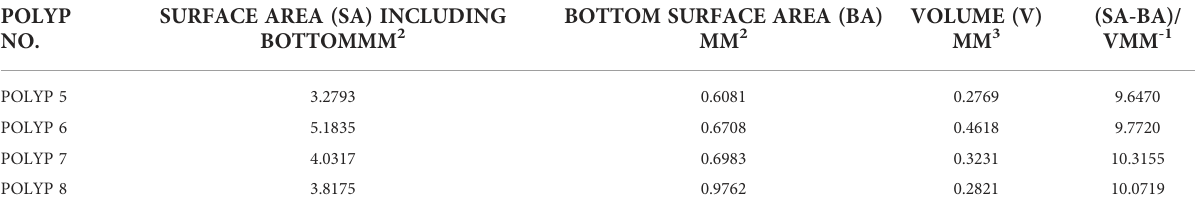
TABLE 1 A summary of the SA, Bottom Area, Volume as well as a ratio for the (4) polyps of the Pocillopora damicornis. POLYP